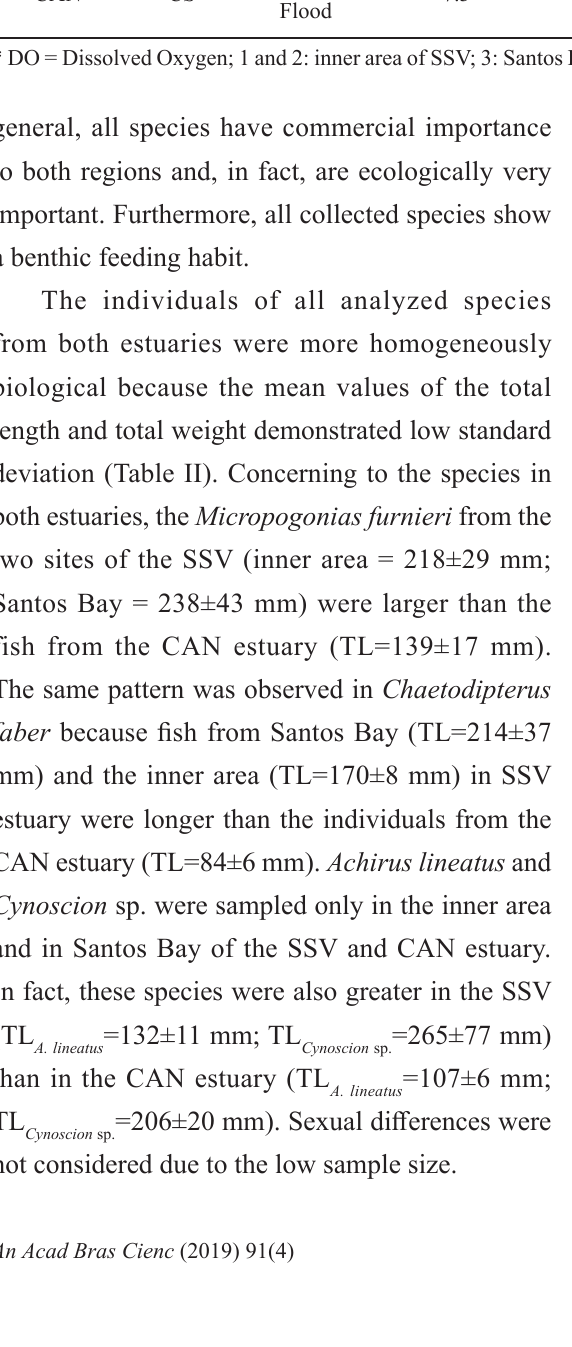
trACE ELEMENt CONCENtrAtIONS Metal concentration in fish species sampled in the SSV and CAN estuaries is shown in Table II. In general, the highest mean concentrations of Co, Zn, and As were obtained in fish from the Santos Bay-